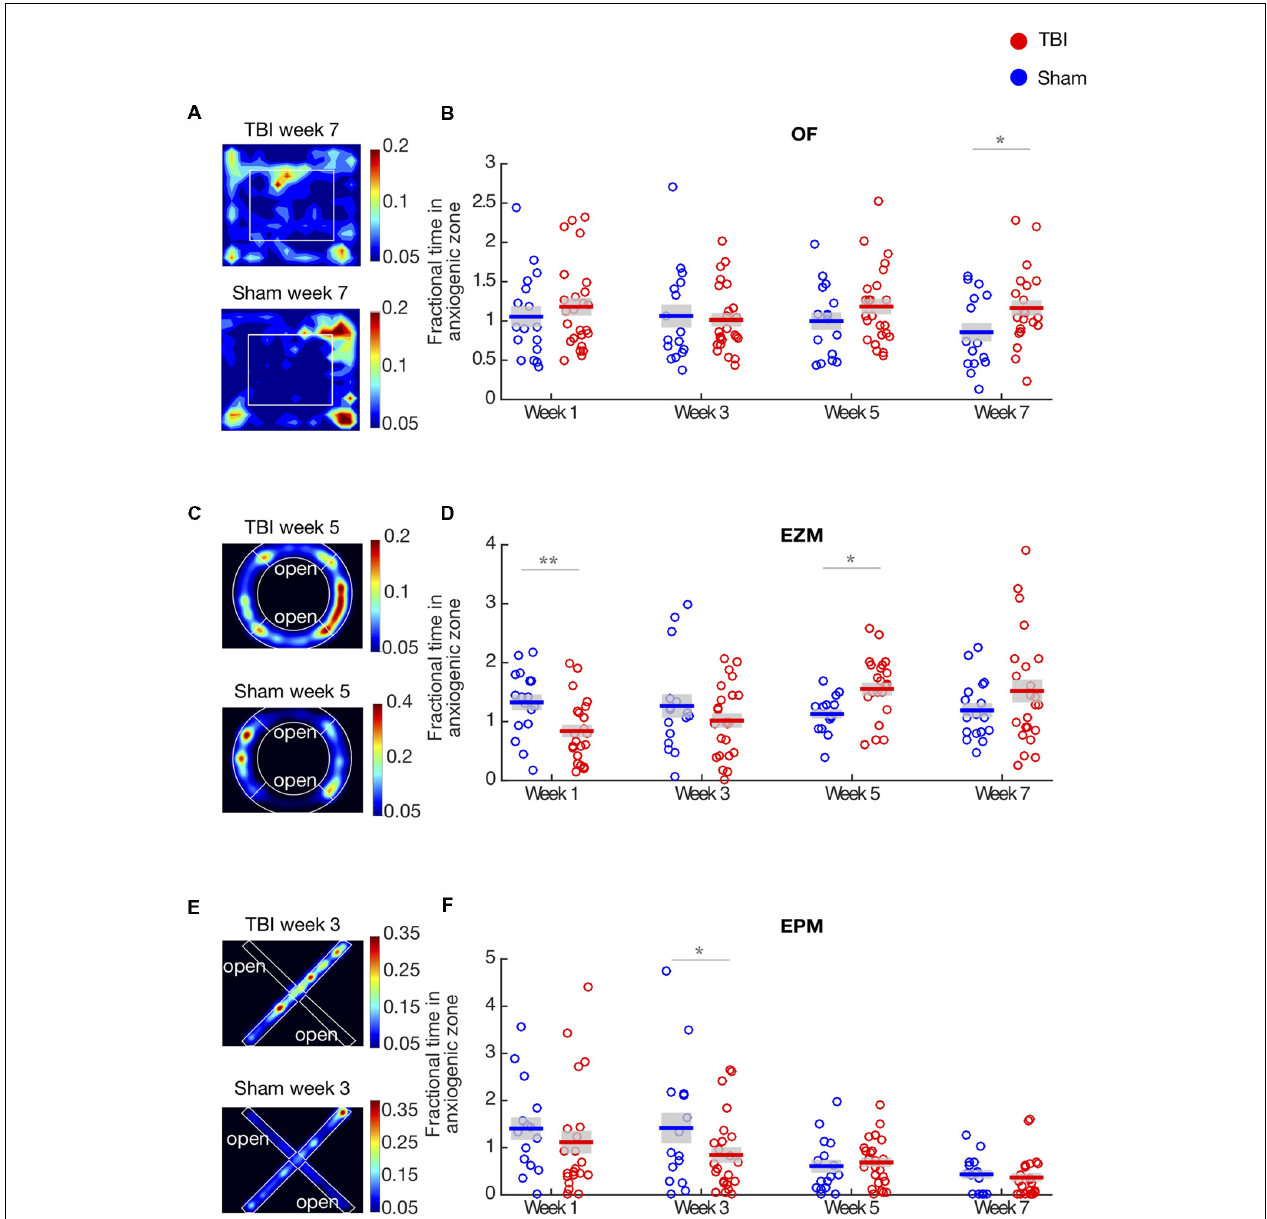
FIGURE 1 | Traumatic brain injury (TBI) causes long-term effects on affective behaviors. (A,C,E) Representative heat maps of TBI and Sham animals in the open field (OF), elevated zero maze (EZM) and elevated plus maze (EPM), respectively. Warmer colors represent that the animals spent more time on that zone. (B) Proportion of time in the center of the OF arena. Each circle represents one mouse. Horizontal bars denote means; shaded regions denote SEM. There is a main effect of injury (repeated two-way ANOVA, p < 0.01) and anxiety significantly decreases on week 7. (D) Proportion of time in the open arm of the EZM; conventions as in (B) . There is an interaction between time and injury (repeated two-way ANOVA, p < 0.01). Anxiety is significantly increased on week 1 and decreased on week 5. (F) Proportion of time in the open arm of the EPM; conventions as in (B) . There is a main effect of injury and time (repeated two-way ANOVA, p < 0.01). Anxiety significantly increases on week 3. Panels (B,D,E) show data are from n = 25 mice in TBI condition, and n = 17 mice in sham condition after removal of outliers at each time point (“Materials and Methods” section); the number of outliers at any time point for any condition did not exceed four mice; ∗ p < 0.05, ∗∗ p < 0.01 by post hoc t -test with false discovery rate (FDR) correction.